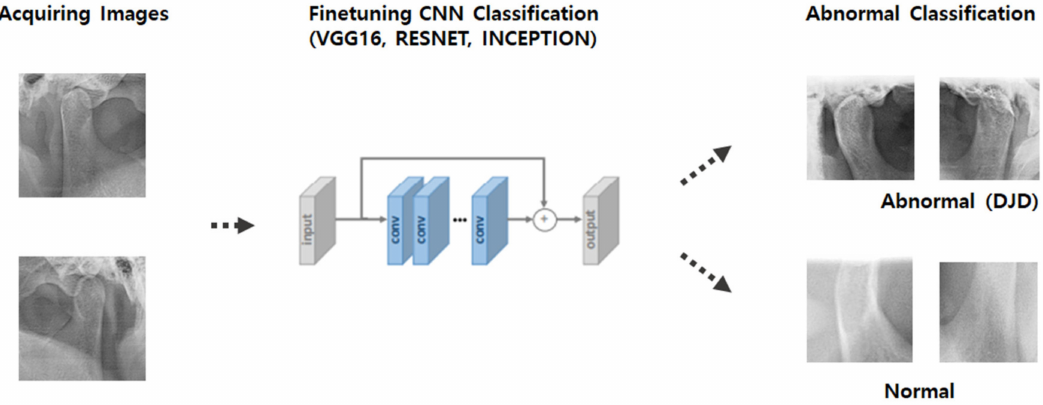
Figure 5. TMJ OA classification model.